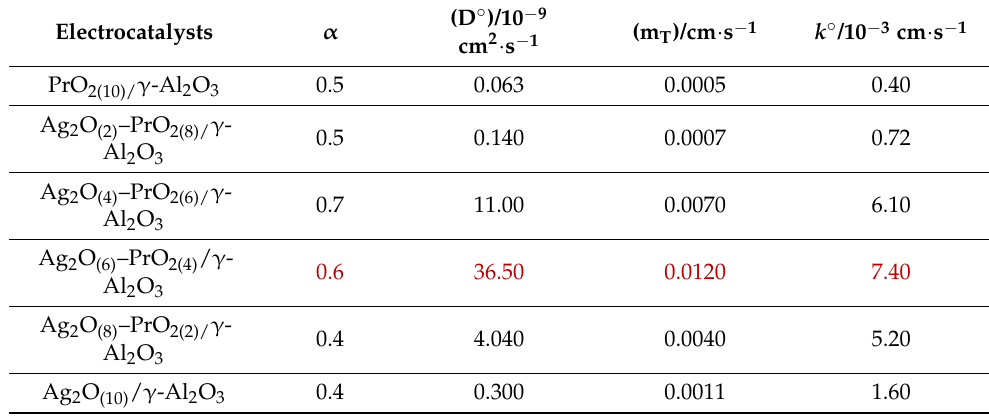
Figure 11. ( a ) Cyclic voltammograms with Ag 2 O (8) –PrO 2(2) / γ -Al 2 O 3 electrode at different concentrations of NH 3 and ( b ) Reinmuth plots between Ip a and C NH3 , showing variation of peak current with C NH3 for and for all modified electrodes. Table 5. Kinetic parameters for NH 3 electro-oxidation at the electrode